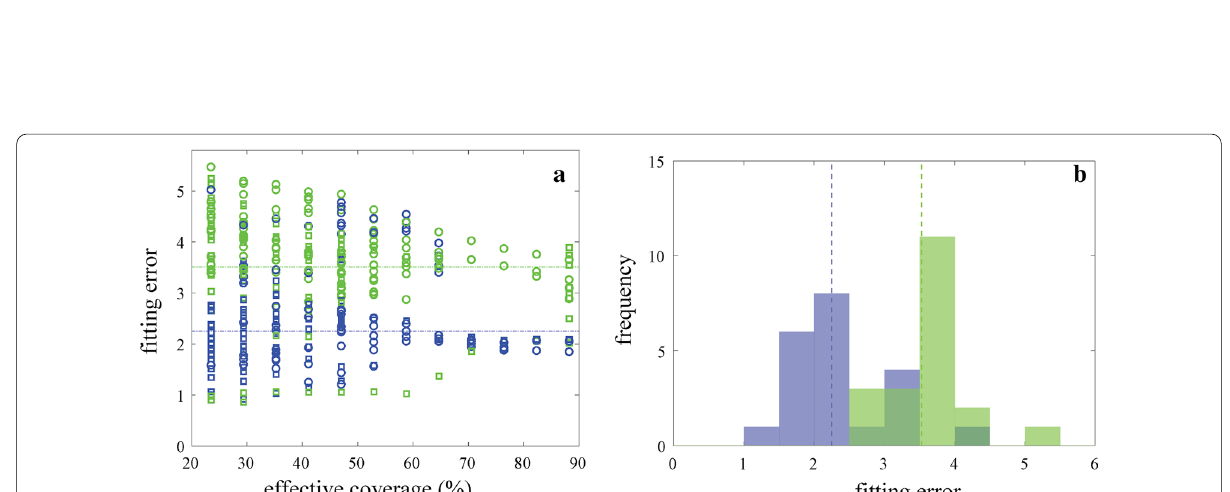
Fig. 7 Expert geoscientists’ ( a ) fitting error by effective coverage, and ( b ) distribution of final fitting error. Fitting error was computed using the data each participant actually received, drawn from datasets corresponding to the given hypothesis (blue) and the alternative-unknown hypothesis (green). The dashed lines of the corresponding colors show the representative fitting error for each dataset, i.e., the fitting error if all possible (220) measurements in that dataset were